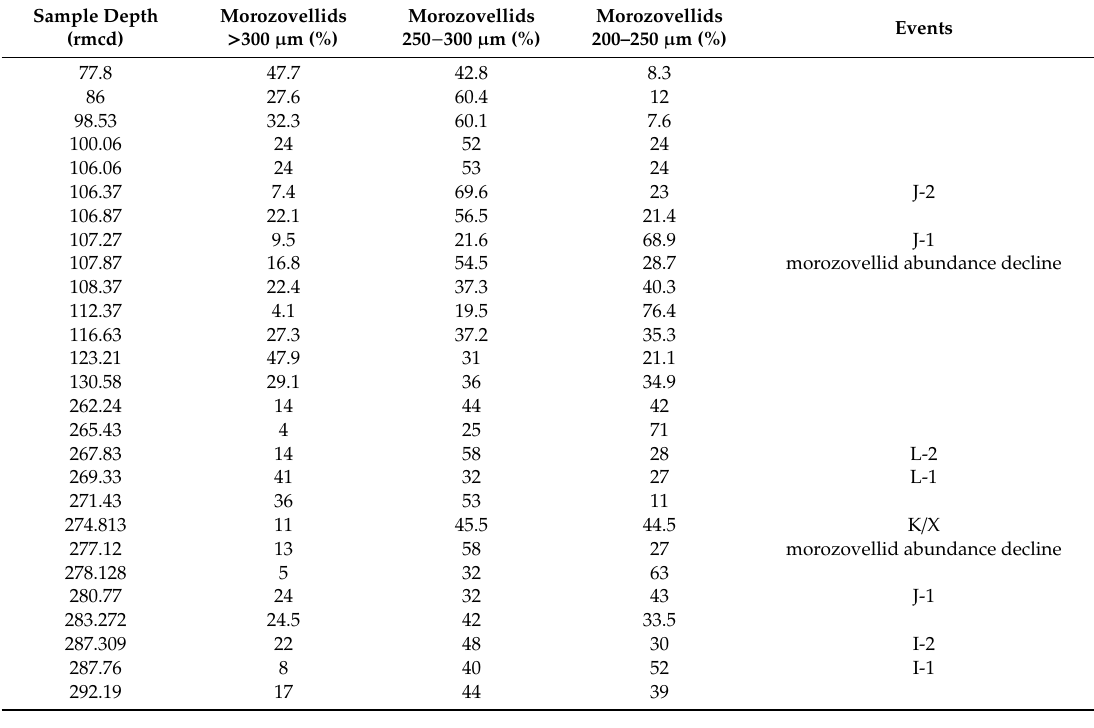
Table 1. Change in morozovellid test-size across the EECO at Site 1258 (above the dashed line) and 1263 (below the dashed line).